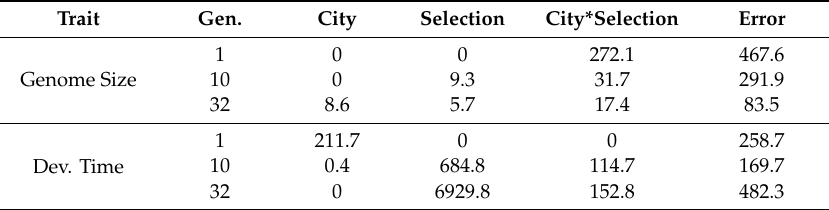
Table 1. Variance component analysis results of genome size and development time in C. macellaria populations. As no di ff erences were found among genome sizes, all strains were merged for the variance analysis of genome size. Variance decreases by generation for City*Selection in genome size. Contrastingly, variance in development time for City*Selection was maintained. Variance increases in selection by generation, verifying successful divergence in phenotypes.